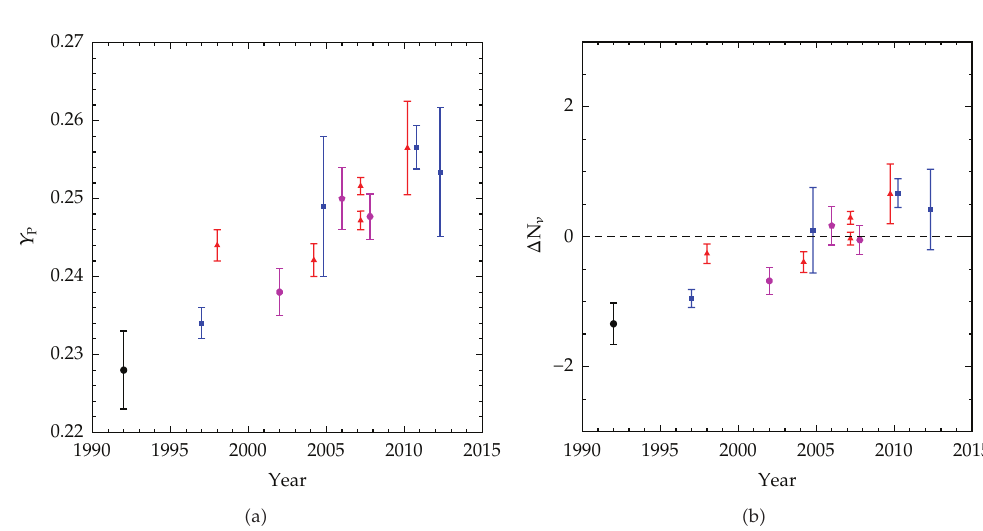
Figure 8: (cid:3) a (cid:4) shows a history of the primordial helium mass fraction (cid:3) Y P (cid:4) determinations as a function of time. The same symbols/colors correspond to determinations from collaborations involving many of the same participants and/or the same observational data (cid:3) blue circle (cid:5) 44 (cid:6) , blue squares (cid:5) 45–48 (cid:6) , red triangles (cid:5) 49–51 (cid:6) , purple circles (cid:5) 52, 53 (cid:6) , and purple pentagon (cid:5) 54 (cid:6)(cid:4) . (cid:3) b (cid:4) shows the corresponding chronology of Δ N ν , determined from BBN using the current best estimate of the primordial deuterium abundance. The dashed line shows the SM result, Δ N ν (cid:7)